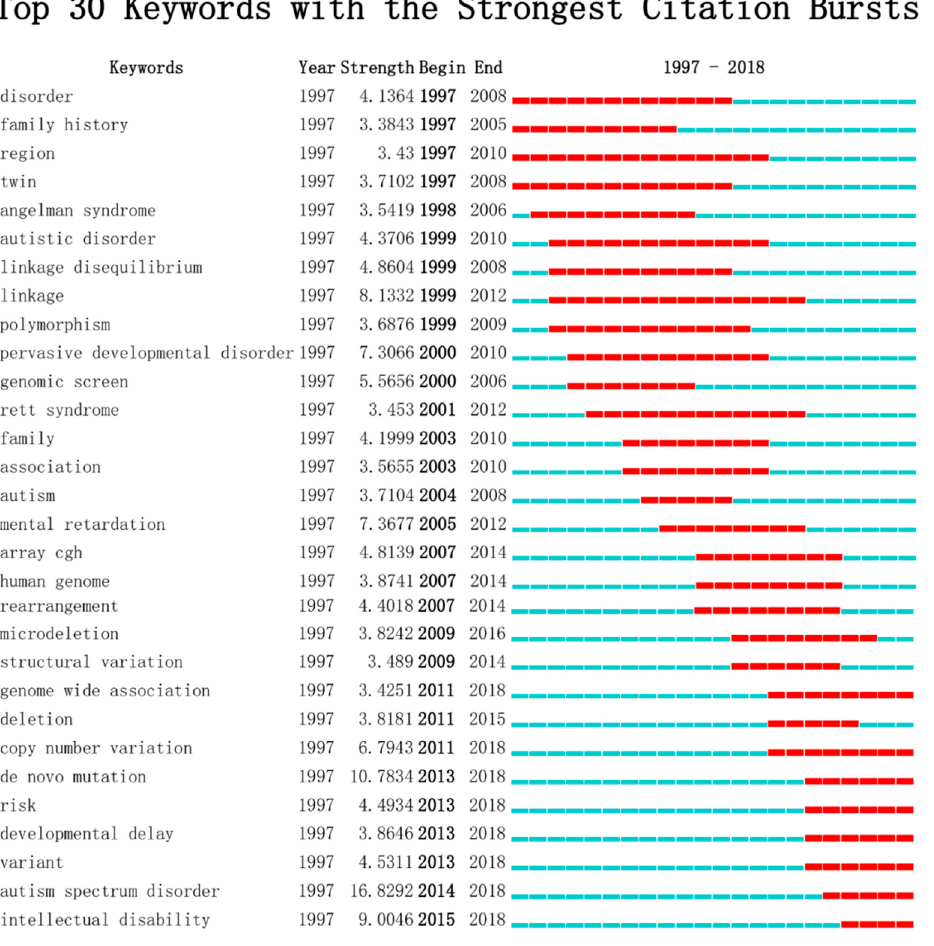
Figure 7. Top 30 keywords with the strongest citation bursts. Keywords with the strongest citation bursts in the scientific literature were analyzed and visualized in the keyword’s burst map. Each short line represents a year, and a line in red stands for the burst detection years. Keywords with red lines extending to the latest year can indicate the research frontiers a short period of time in the future.